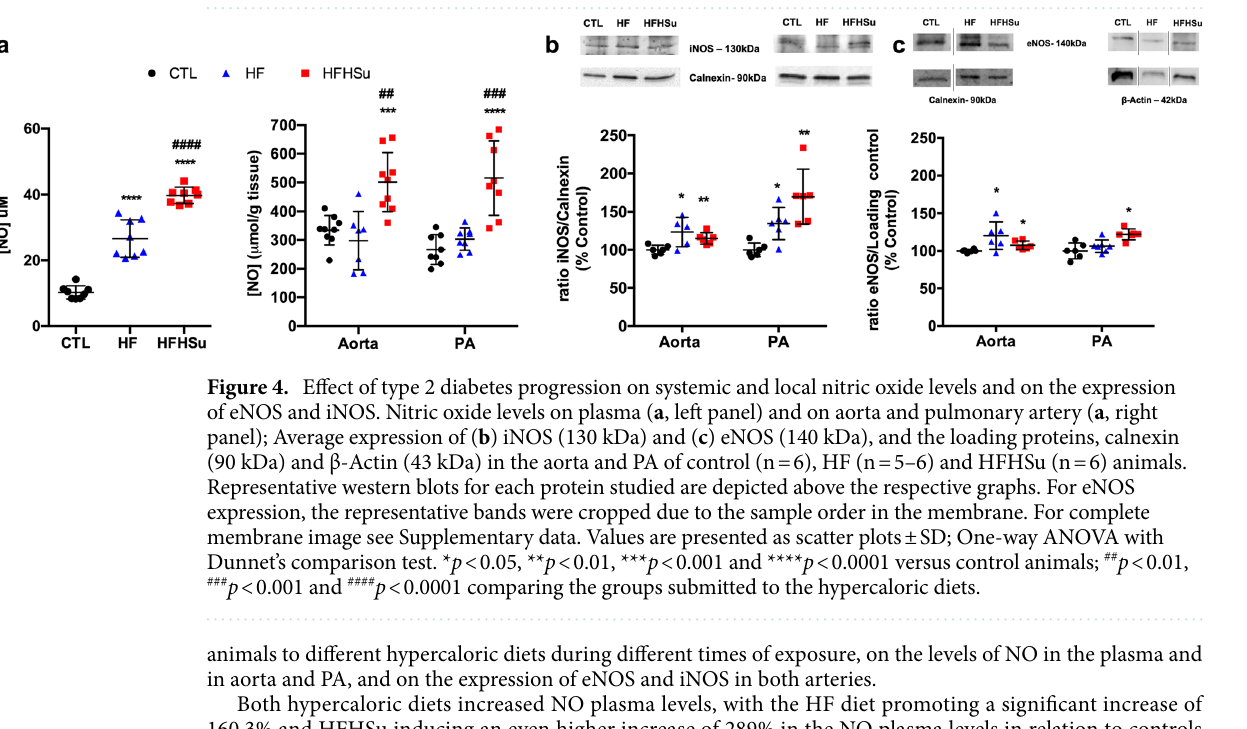
Figure 3. Effect of prediabetes and early phase type 2 diabetes on PGF2α levels in plasma and on the expression of PGF2α receptor. ( a ) PGF2α levels in plasma of control animals (n = 6) and animals submitted to HF (n = 4) or HFHSu (n = 6) diets. ( b ) Average relative expression of PGF2α receptor (60KDa) and the loading protein β-Actin (43 kDa) or GAPDH (37 kDa) in aorta and pulmonary artery (PA) of control animals (n = 6) and animals submitted to HF (n = 6) and HFHSu (n = 6) diets. Representative western blots for each protein studied are depicted above the respective graphs. For PGF2α expression, the representative bands were cropped due to the sample order in the membrane. For complete membrane image see Supplementary data. Values are presented as scatter plots ± SD; One-way ANOVA with Dunnet’s comparison test. ** p < 0.01 and *** p < 0.001 versus control animals.